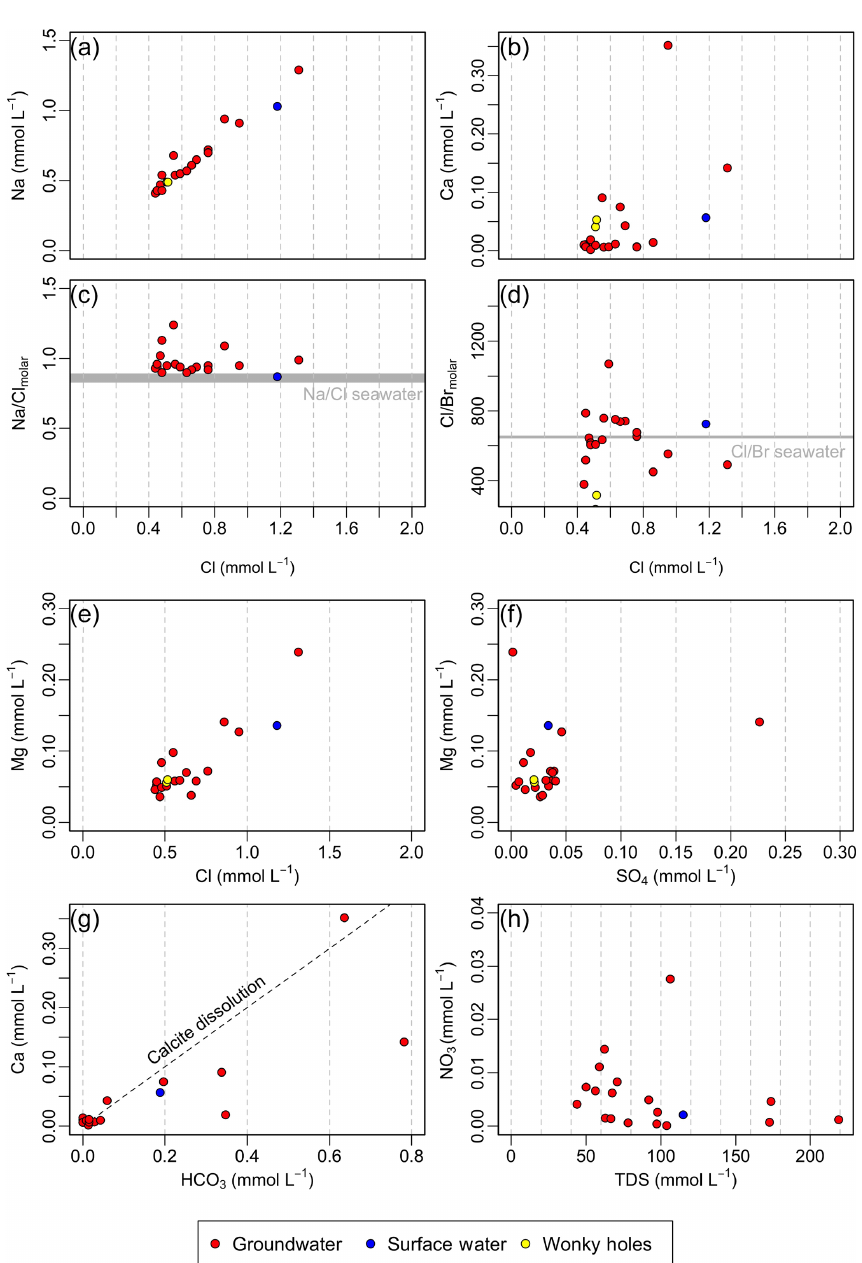
Figure 3. Geochemistry of surface water and groundwater from the bores and wonky holes. (a) Na vs. Cl, (b) Ca vs. Cl, (c) Na/Cl vs. Cl, (d) Cl/Br vs. Cl, (e) Mg vs. Cl, (f) Mg vs. SO 4 , (g) Ca vs. HCO 3 and (h) NO 3 vs.